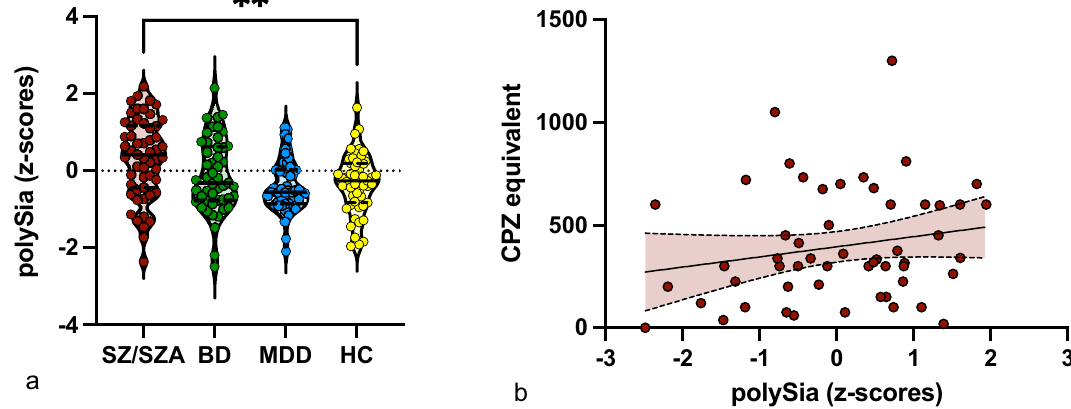
Figure 1. Serum levels of polySia are increased in SZ/SZA. Shown are mean serum levels of polySia in different patient subgroups ( a ) and comparison between the polySia serum level and the chlorpromazine equivalent ( b ). ( a ) Serum levels of polySia were increased in SZ/SZA compared to HC (* p < .05; ** p < 0.01). ( b ) No correlation ( p = < .97) between the polySia serum levels and the chlorpromazine (CPZ) equivalent in the medication treated cohort of patients with SZ/SZA, BD and MDD. Error bars represent standard deviation from the